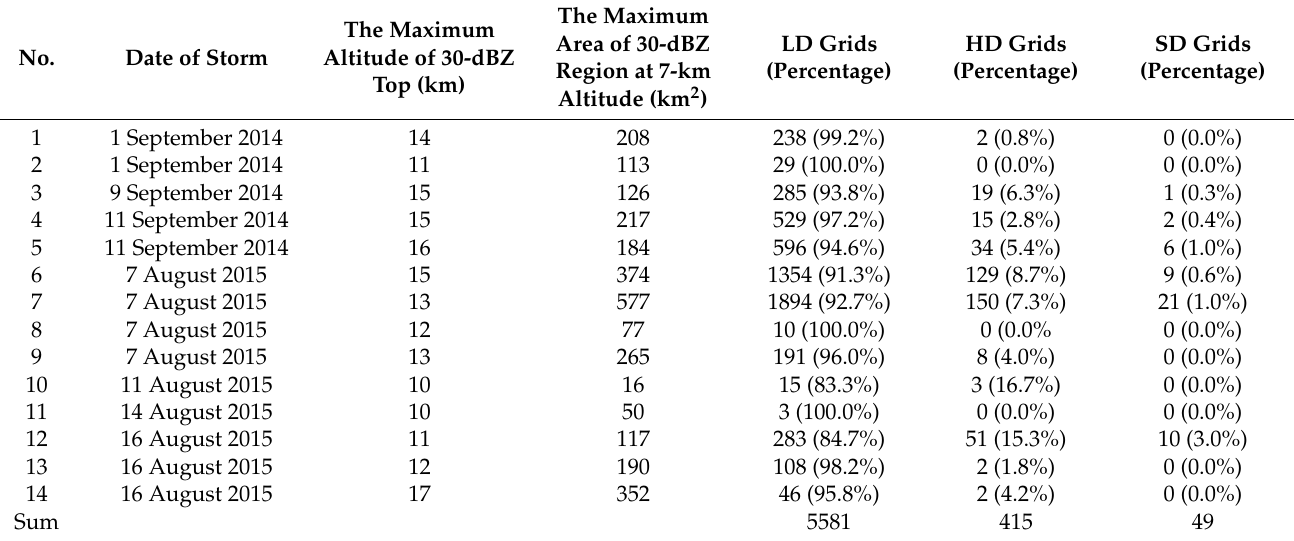
Table 1. The distribution of the LD, HD and SD grids in the 14